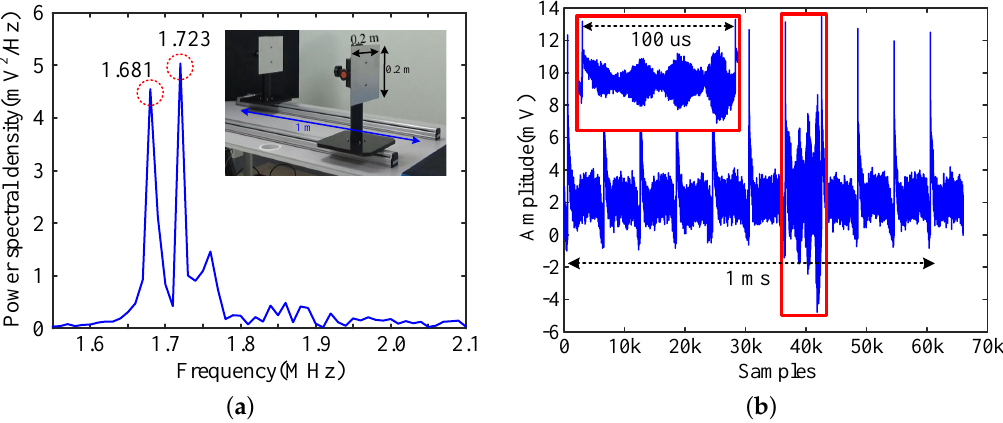
Figure 6. Characteristics of de-chirped signal. ( a ) Power spectral density of the de-chirped signal and picture of targets. ( b ) De-chirped signal representation in time